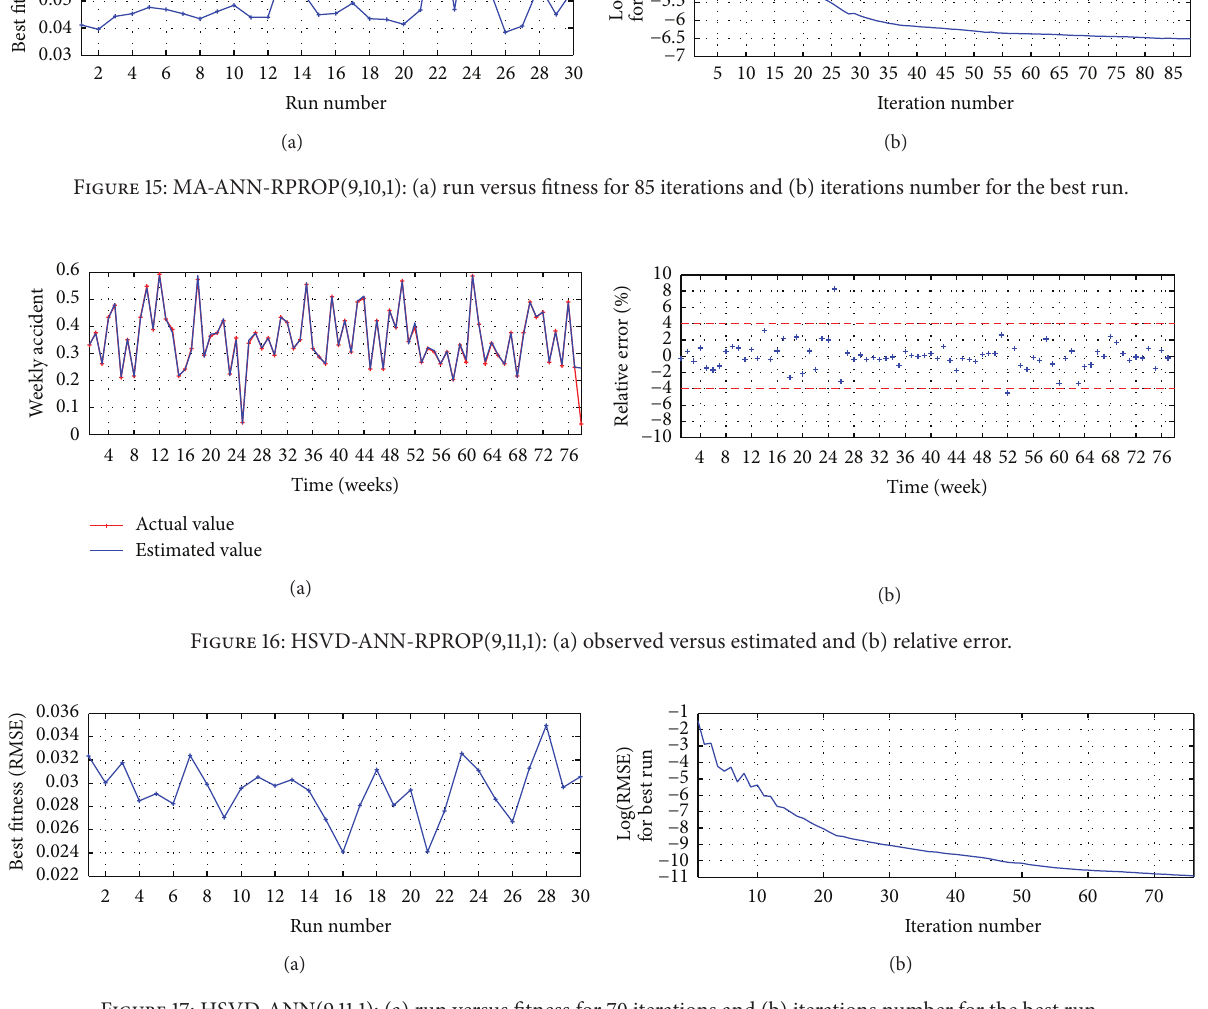
Figure 17: HSVD-ANN(9,11,1): (a) run versus fitness for 70 iterations and (b) iterations number for the best